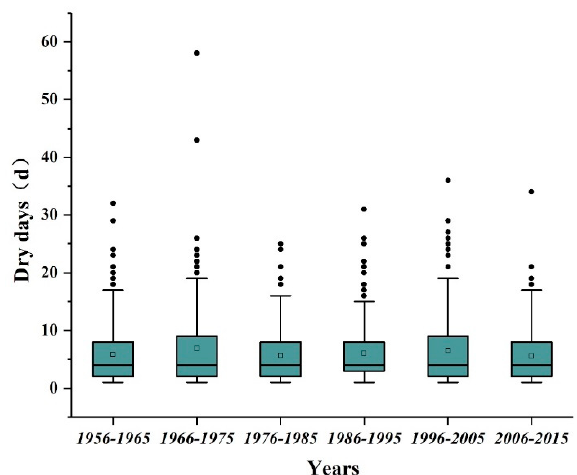
Figure 4. Box and whisker plots of dry period in the basin during 1956–2015. The horizontal line in the box represents the median of the distribution (50% of the data are greater than this value), and the upper and lower box limits represent the upper and lower quartiles (25% of data greater / lower than the value), respectively. Maximum and minimum values are indicated by the top and bottom horizontal lines. The outlier points show values of more than two-thirds of the quantile.